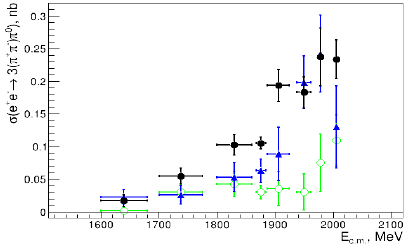
Figure 11. The e + e − → 3( π + π − ) π 0 cross sec- tion measured with the CMD-3 detector at VEPP- 2000 (dots). The contributions from the e + e − → 2( π + π − ) η and e + e − → 2( π + π − ) ω reactions are shown by triangles and open circles, respectively.